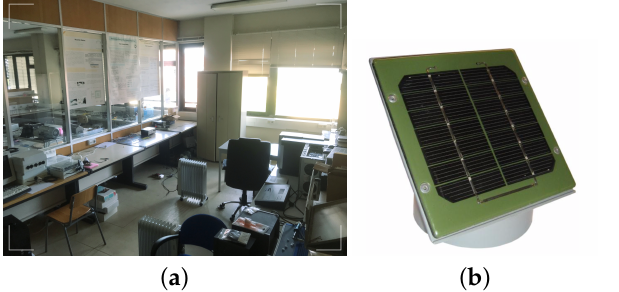
Figure 2. ( a ) Room used for the thermostatic control system evaluation; ( b ) photovoltaic panel used for the measurement of the solar